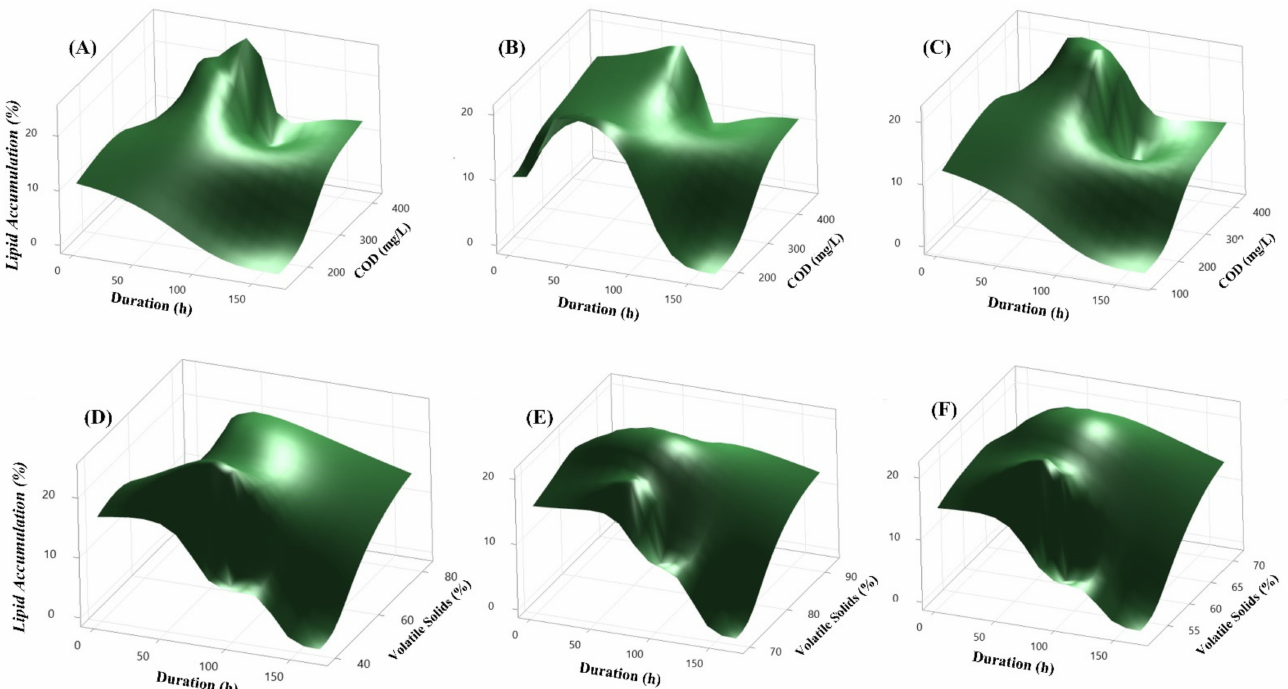
Figure 4. Surface Plot of Lipid Accumulation by bacterial isolate KM1 in different types of waste vs. COD and Volatile solids: ( A ) COD in AW, ( B ) COD in MW, ( C ) COD in OW, ( D ) Volatile solids in AW, ( E ) Volatile solids in MW and ( F ) Volatile solids in